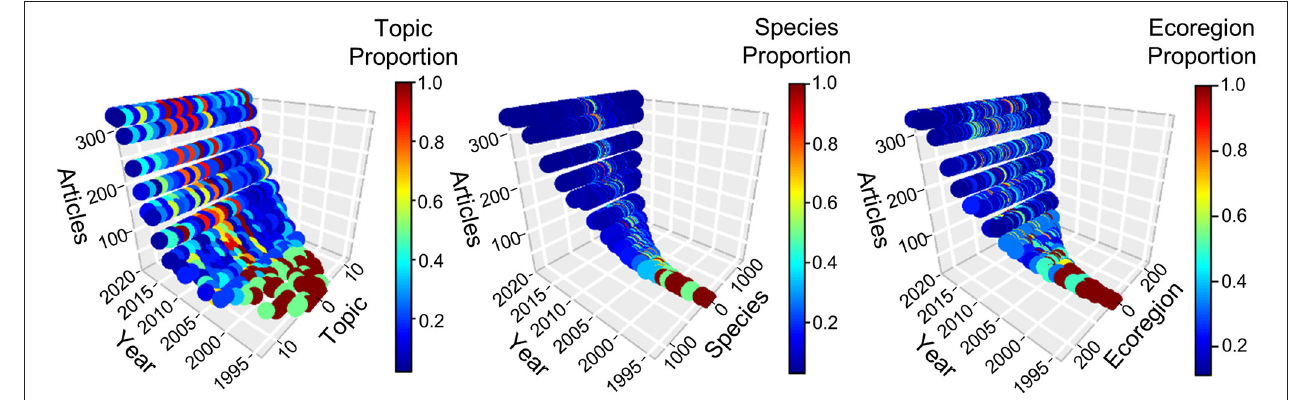
FIGURE 2 | Technological diffusion in camera trapping, 1994–2020. Each panel depicts adoption as number of published articles and one of three categories of CT application: topic, species, and ecoregion. Colors represent the relative fraction of uses for applications at a given time, scaled so the application with maximum use at that time received a value of one. Numeric values were assigned arbitrarily to an application but remained fixed throughout the time series. Detailed assessments of application diversification are presented in subsequent figures. Counts for 2020 were prorated to an annual basis from a search conducted 14 August 2020.